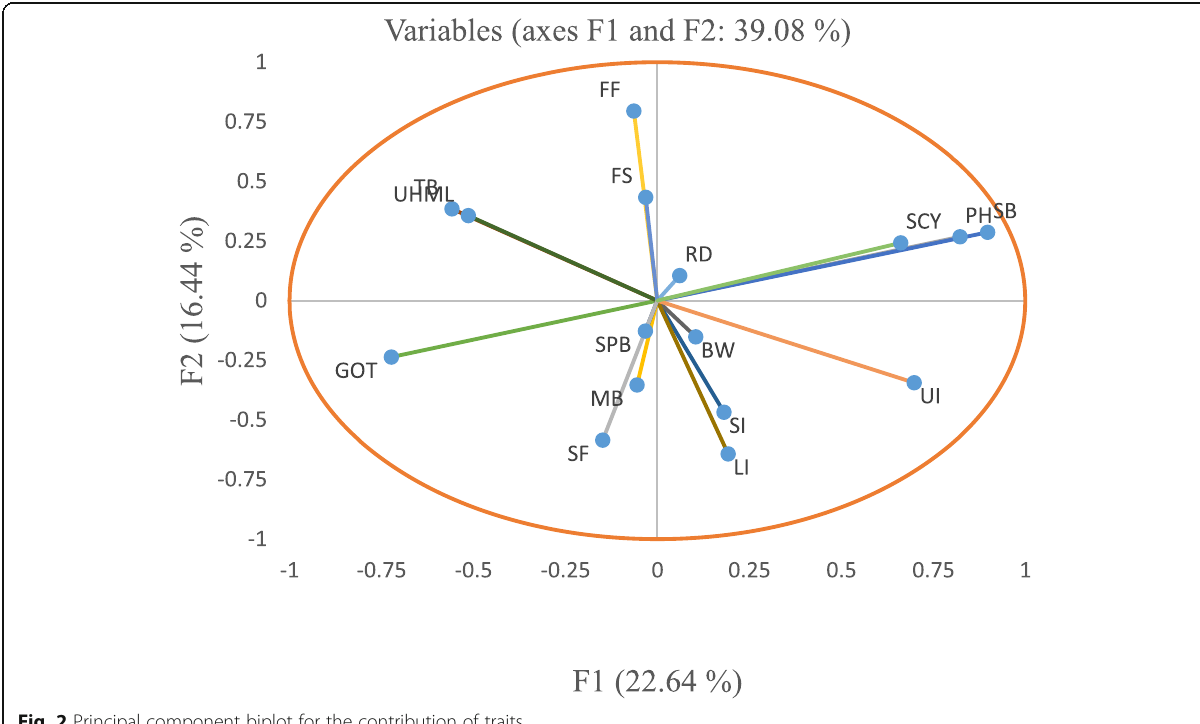
Fig. 2 Principal component biplot for the contribution of